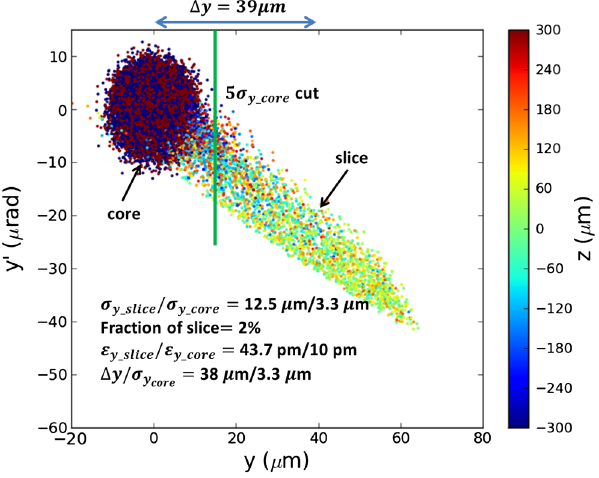
FIG. 11. Phase space for y versus y 0 right at the radiator at 26